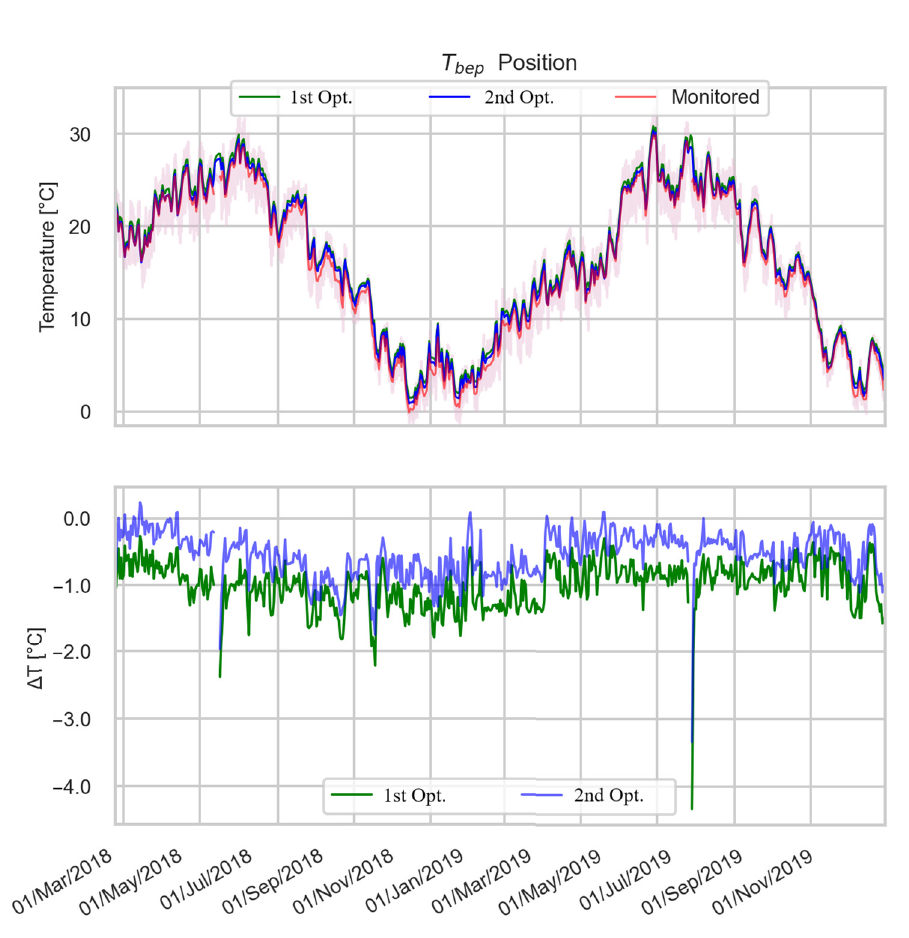
Figure 8. Comparison of the curve of the monitored temperature values at position T bep (in red including the shadow air of the measurement uncertainty) with the curve of the first optimized simulation (in green) and the second optimized simulation (blue).